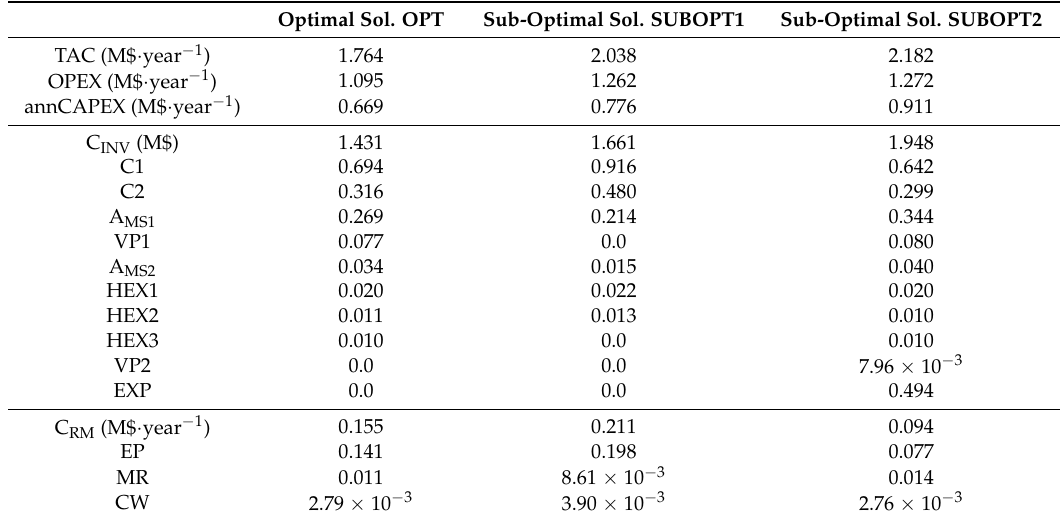
Table 2. Comparison of the optimal cost values of the three solutions OPT, SUBOPT1, and SUBOPT2. Optimal Sol.